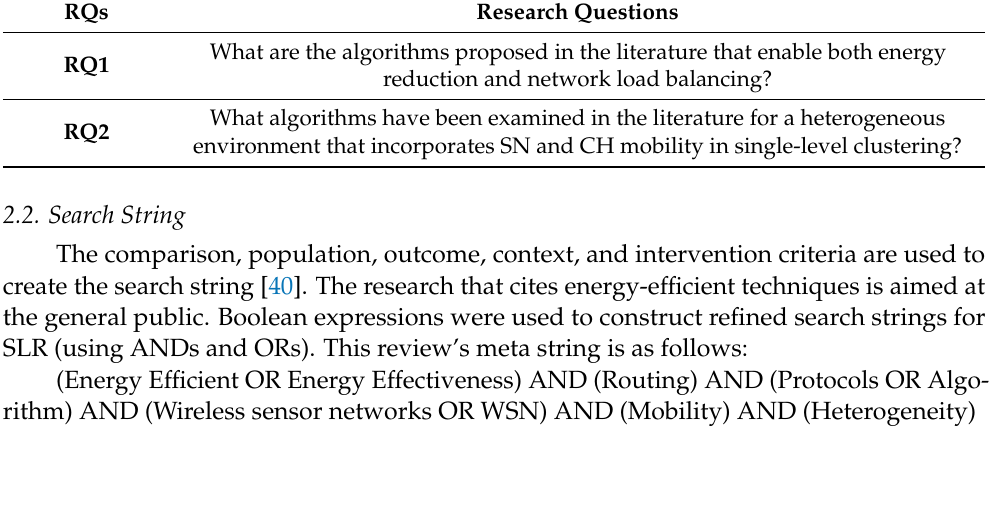
Table 1. Research Table 1. Research questions.